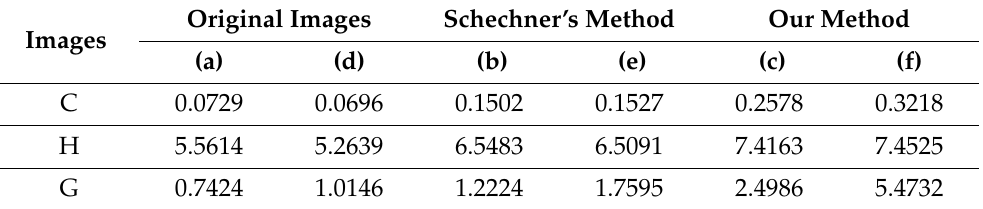
Table 2. The quantitative evaluation results of the original images and the dehazed images in Figure